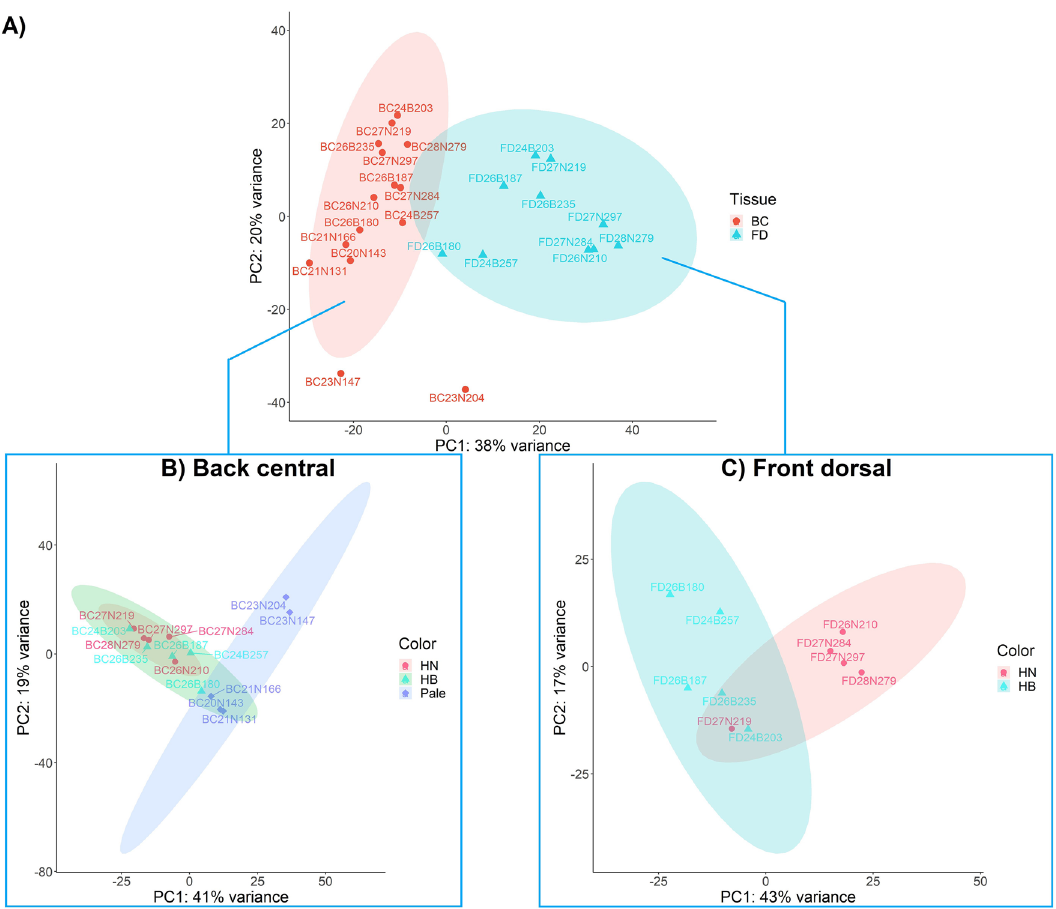
Figure 4. Principal component analysis (PCA) of sequencing data comparing two muscle regions and three phenotypic groups within each region. ( A ) The comparison of FD and BC regions; ( B ) Comparison of HN, HB and Pale fish in the BC region; ( C ) Comparison of HN and HB fish in the FD region. BC back central region, FD front dorsal region, HN high red color-no banding fish, HB high red color-banded fish, Pale